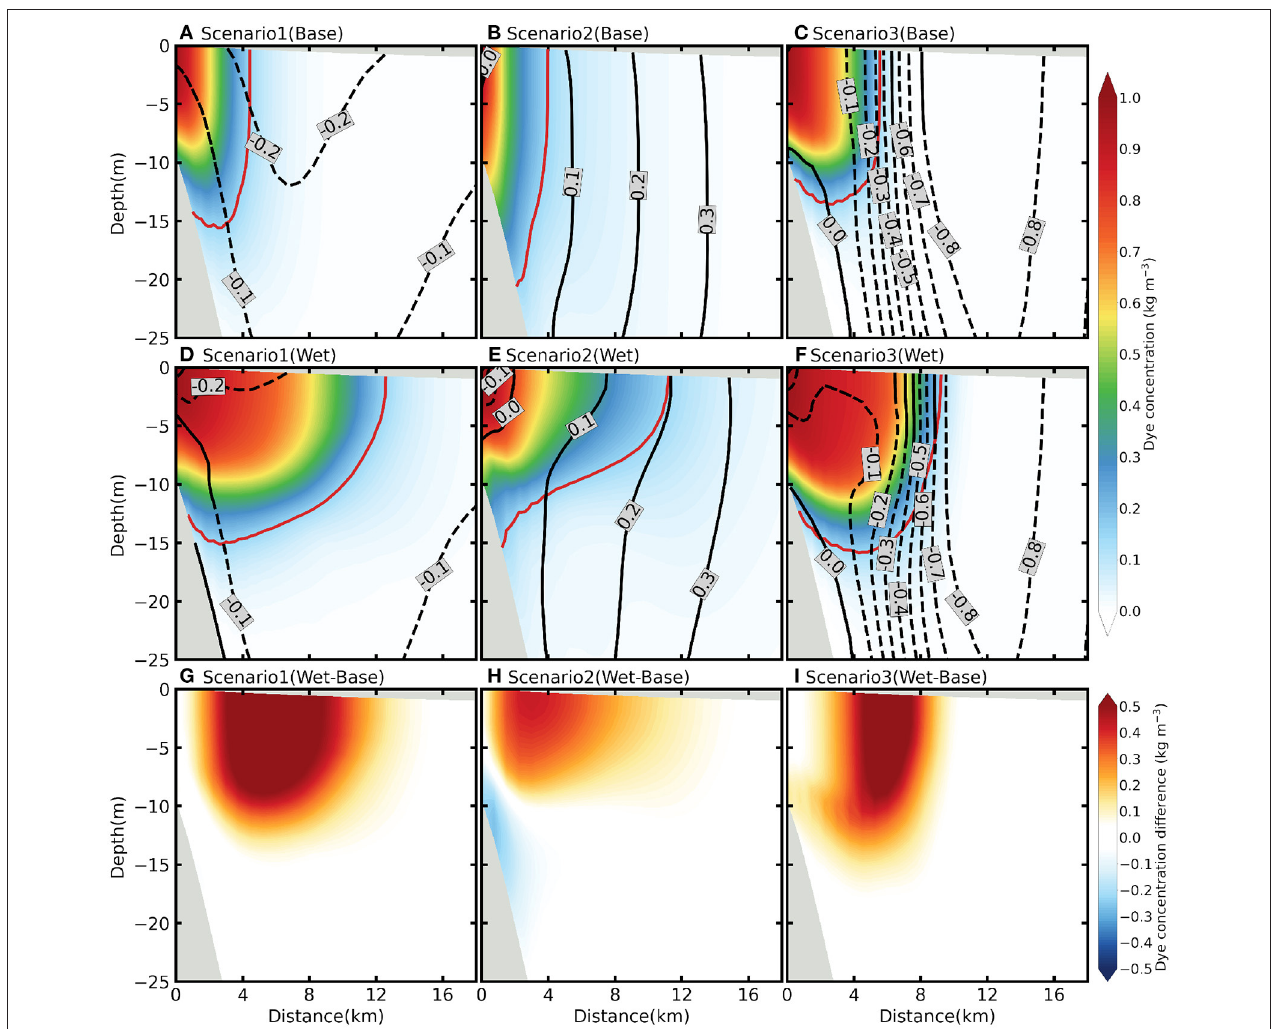
FIGURE 7 | Cross-section profiles of dye concentration averaged over the first 4 days within the purple box in Figure 6 for each EAC scenario and their differences between the wet event and the base case. (A–C) Cross-sections profiles of dye concentration for EAC scenario 1, EAC scenario 2, and EAC scenario 3 in the base case. The solid and dashed black lines show the northward and southward velocities, respectively. The red line indicates the contour of 0.15 dye concentration. (D–F) Same as (A–C) , but for the wet event. (G–I) Differences of dye concentration for three EAC scenarios between the wet event (D–F) and the base case (A–C) . Only the dye concentration profiles less than 18 km from the river mouth are